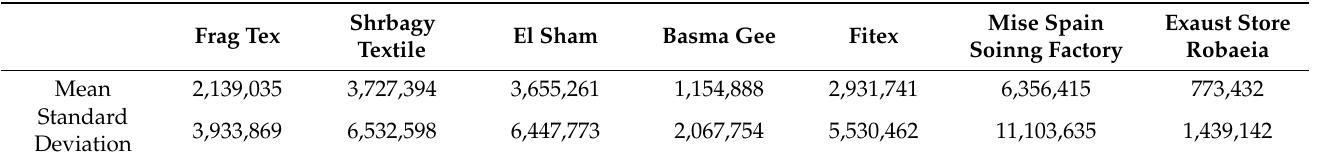
Table 7. The mean and standard deviation of each case